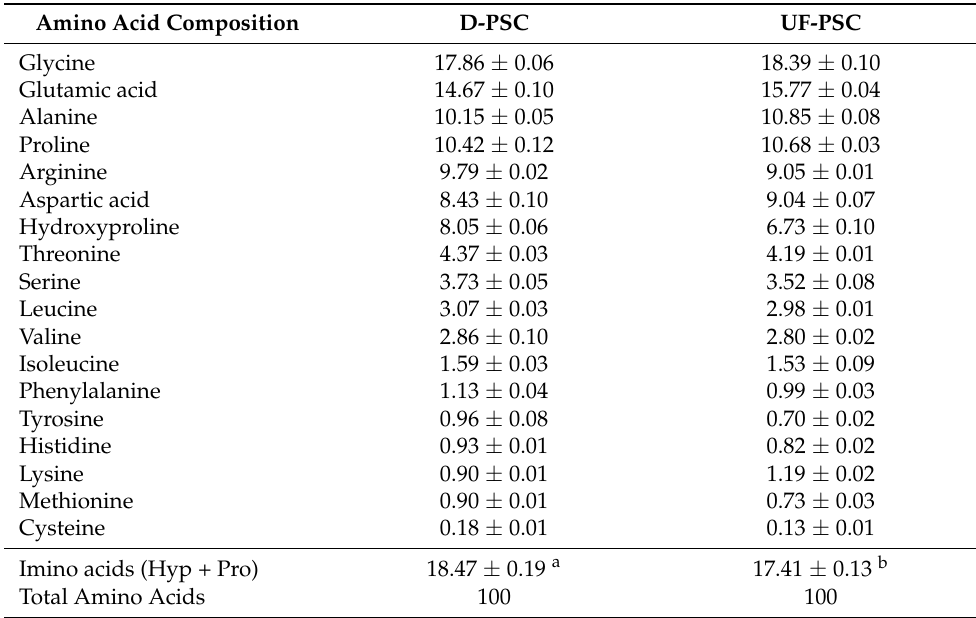
Table 2. Amino acid composition of D-PSC and